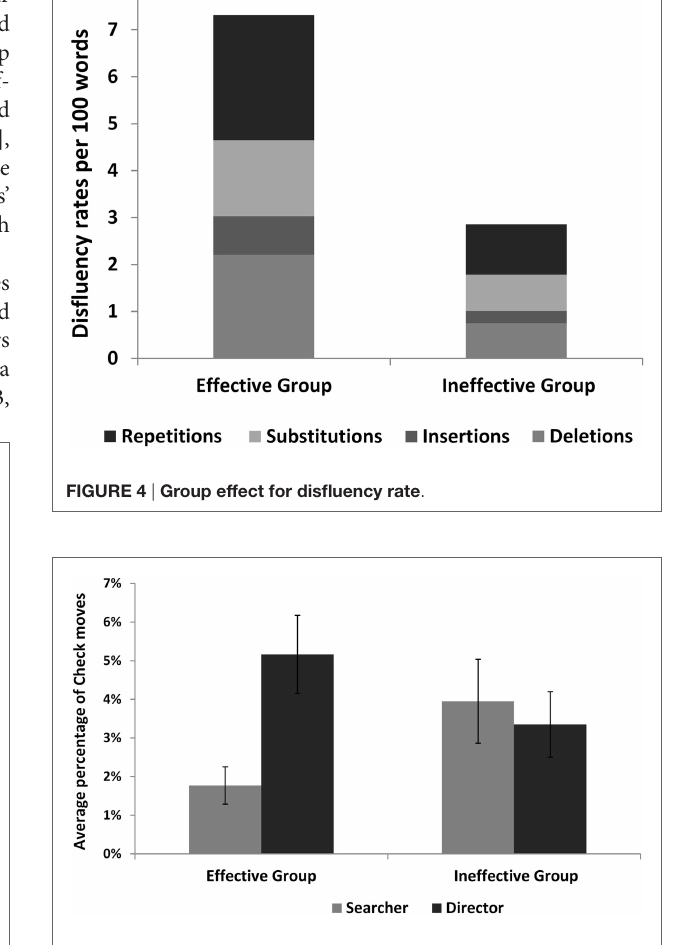
FigUre 5 | group × speaker interaction for Check moves . Error bars represent